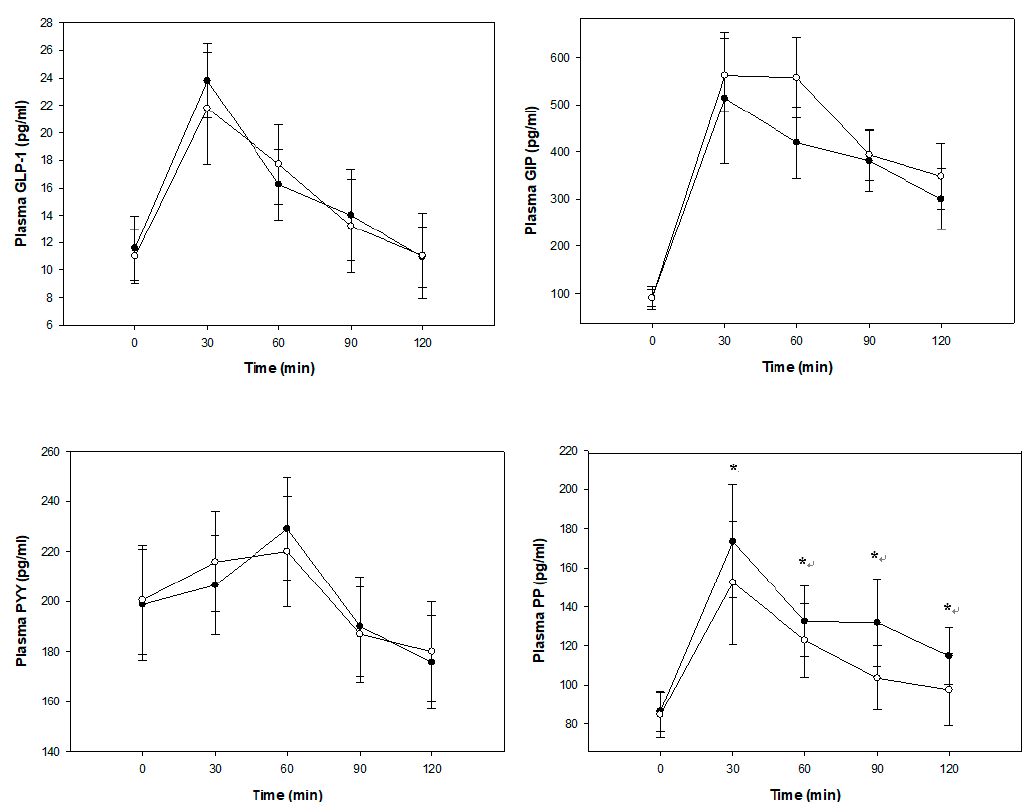
Figure 3. Gastrointestinal hormone concentrations after consumption of the blueberries ( • ) or placebo gel ( ○ ) breakfast meals. Data are presented as arithmetic means ± SE, n = 17. All times points were significantly different from baseline, p < 0.05. For glucagon-like peptide-1 (GLP-1), glucose-dependent insulinotropic peptide (GIP), and peptide YY (PYY) there were no significant differences between responses from the blueberry or placebo breakfast meals; pancreatic polypeptide (PP) responses were significantly different after consumption of the blueberry breakfast meal than the placebo breakfast meal, p < 0.05*.